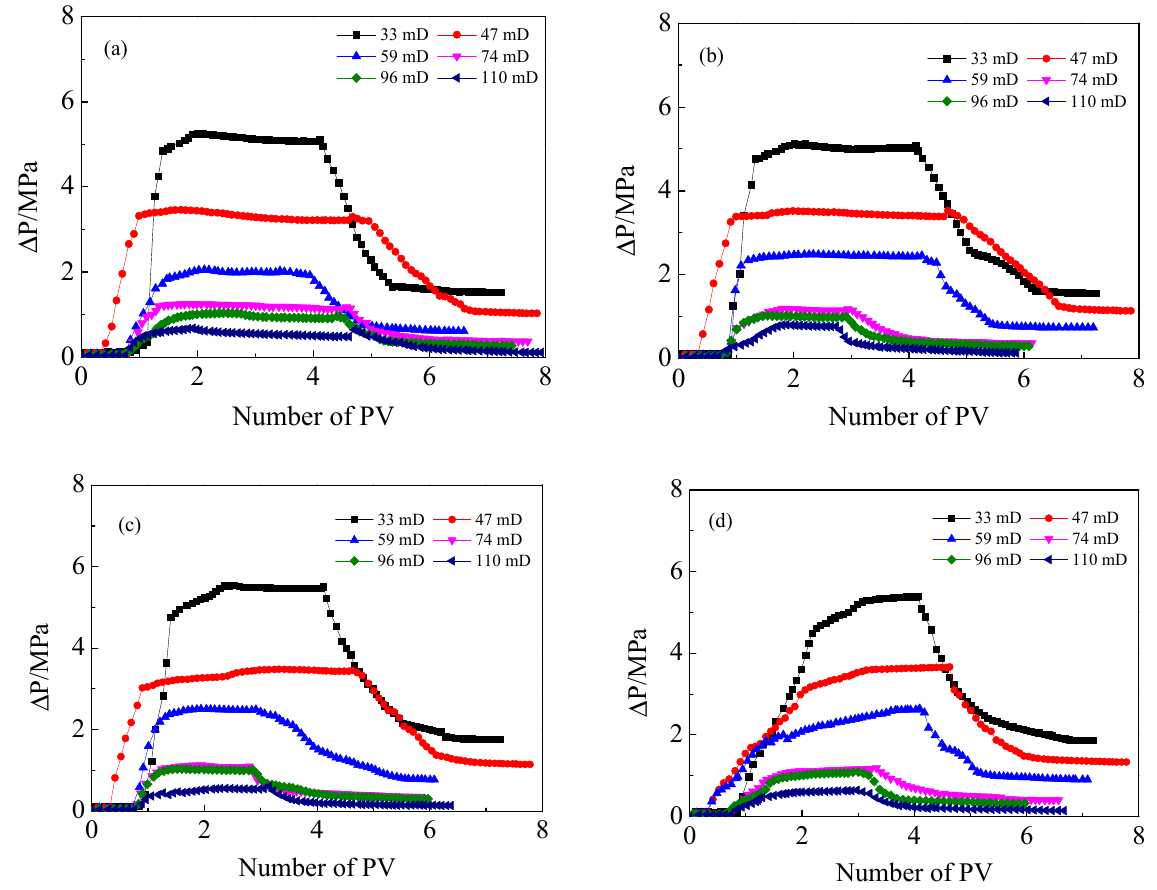
Figure 4. Pressure gradient ( Δ P) as a function of pore volume (PV) of injected in HW-HPAM flow in different permeability cores. ( a ) 0.8 g ⋅ L − 1 , ( b ) 1.5 g ⋅ L − 1 , ( c ) 2.3 g ⋅ L − 1 and ( d ) 3.0 g ⋅ L − 1 .